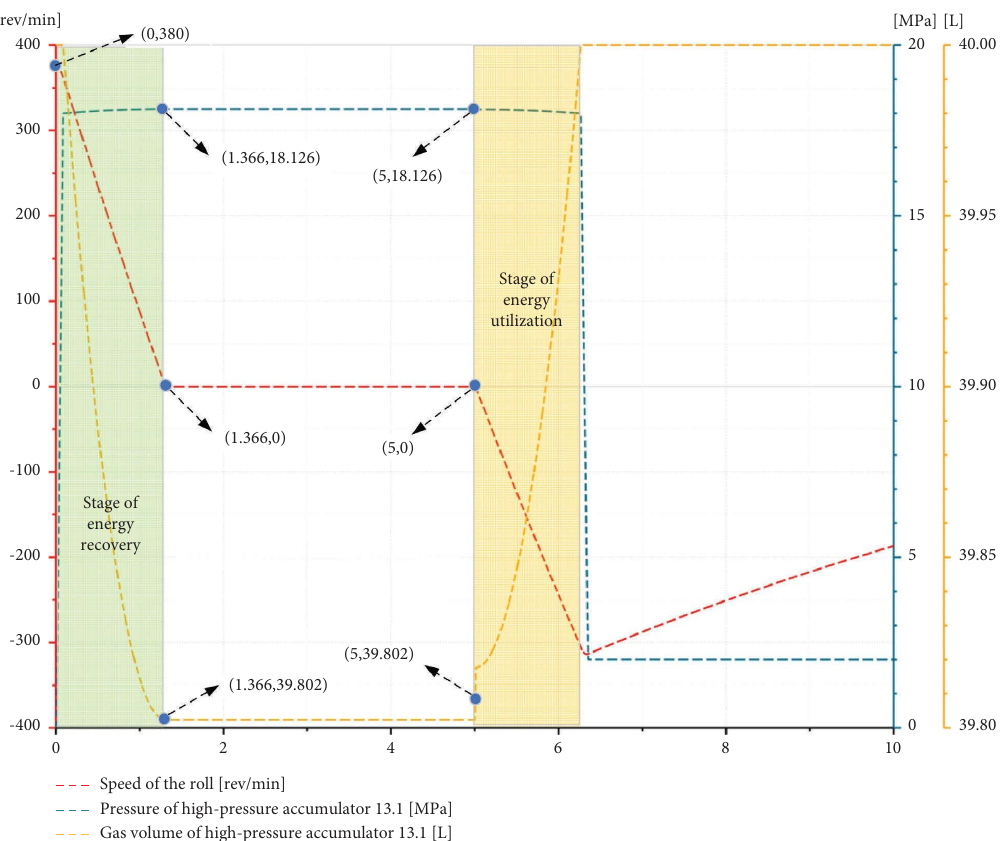
Figure 9: High-pressure accumulator change in pressure and volume and roll speed change.